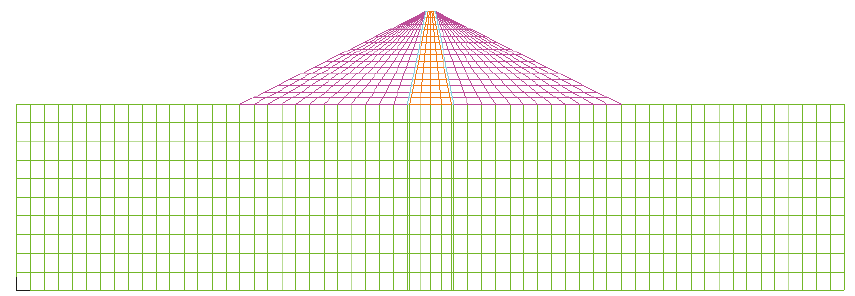
Figure 14: Finite element